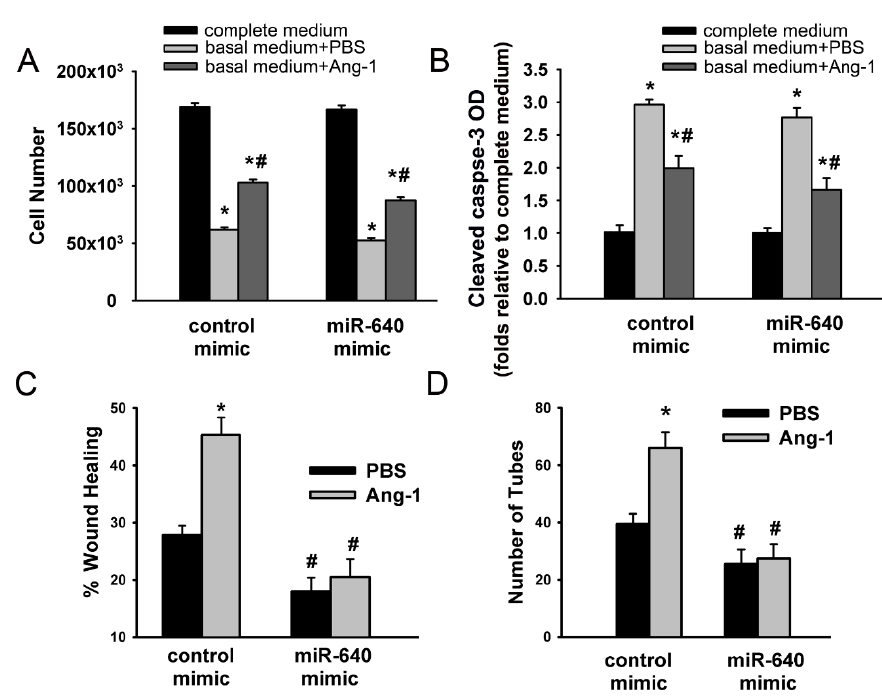
Figure 2. Effects of the miR-640 mimic on cell survival, migration, and differentiation. (A and B): HUVECs were transfected with control or miRNA 640 mimics. Equal numbers of cells were then maintained in complete (20% FBS), basal medium (2% FBS) containing PBS, or Ang-1 (300 ng/mL). Cell numbers and cleaved caspase-3 optical densities (OD) were evaluated 24 h later. Values are means ± SEM. * p < 0.05, compared to cells maintained in complete medium. # p < 0.05, compared to PBS. ( C ): Scratch wound healing in HUVECs transfected with control or miR-640 mimics and cultured in basal medium containing PBS or Ang-1. Percentage wound healing was measured 8 h after wounding with a pipette tip. Values are means ± SEM. * p < 0.05, compared to PBS. # p < 0.05, compared to cells transfected with the control mimic and treated with PBS or Ang-1. ( D ): Total tube numbers of HUVECs transfected with control or miR-64 mimics and maintained for 24 h in plates precoated with growth factor-reduced Matrigel and basal medium containing PBS or Ang-1. Values are means ± SEM. * p < 0.05, compared to PBS. # p < 0.05, compared to corresponding cells transfected with the control mimic and treated with PBS or